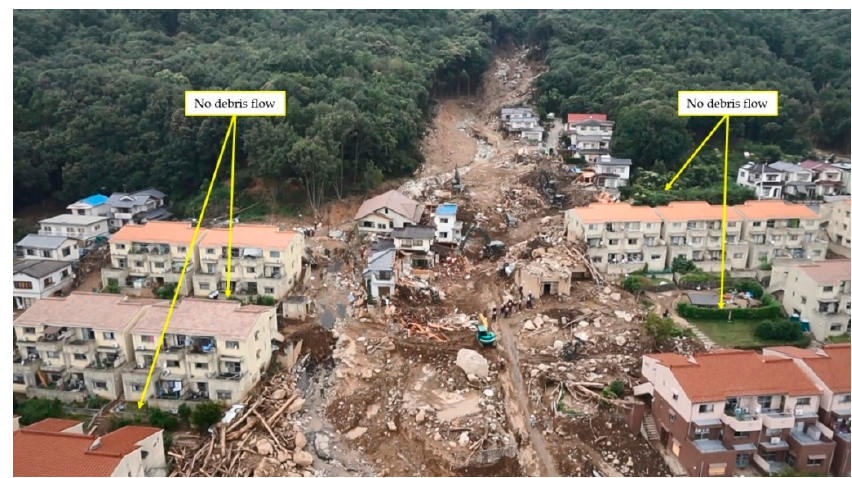
Figure 12. Debris flow no-inundation areas in the downstream reinforced concrete building area. Photo was taken by Luce Search Inc.